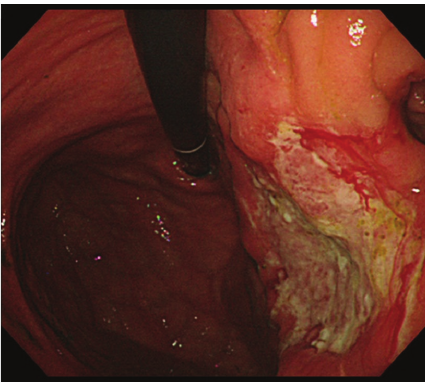
Figure 1: Upper gastrointestinal fiberscopy findings. There was the ulcerated tumor about 4cm in size (type 3). The tumor was found at theremnantstomachandinvadedtotheanastomoticsiteofBillroth- II